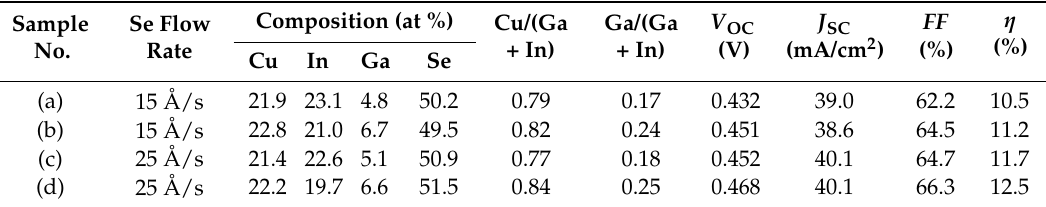
Table 1. Composition ratios and performance parameters of CIGS solar cells with (a) low and (b) high Ga contents selenized at low Se flow rate (15 Å/s), and of CIGS solar cells with (c) low and (d) high Ga contents selenized at high Se flow rate (25